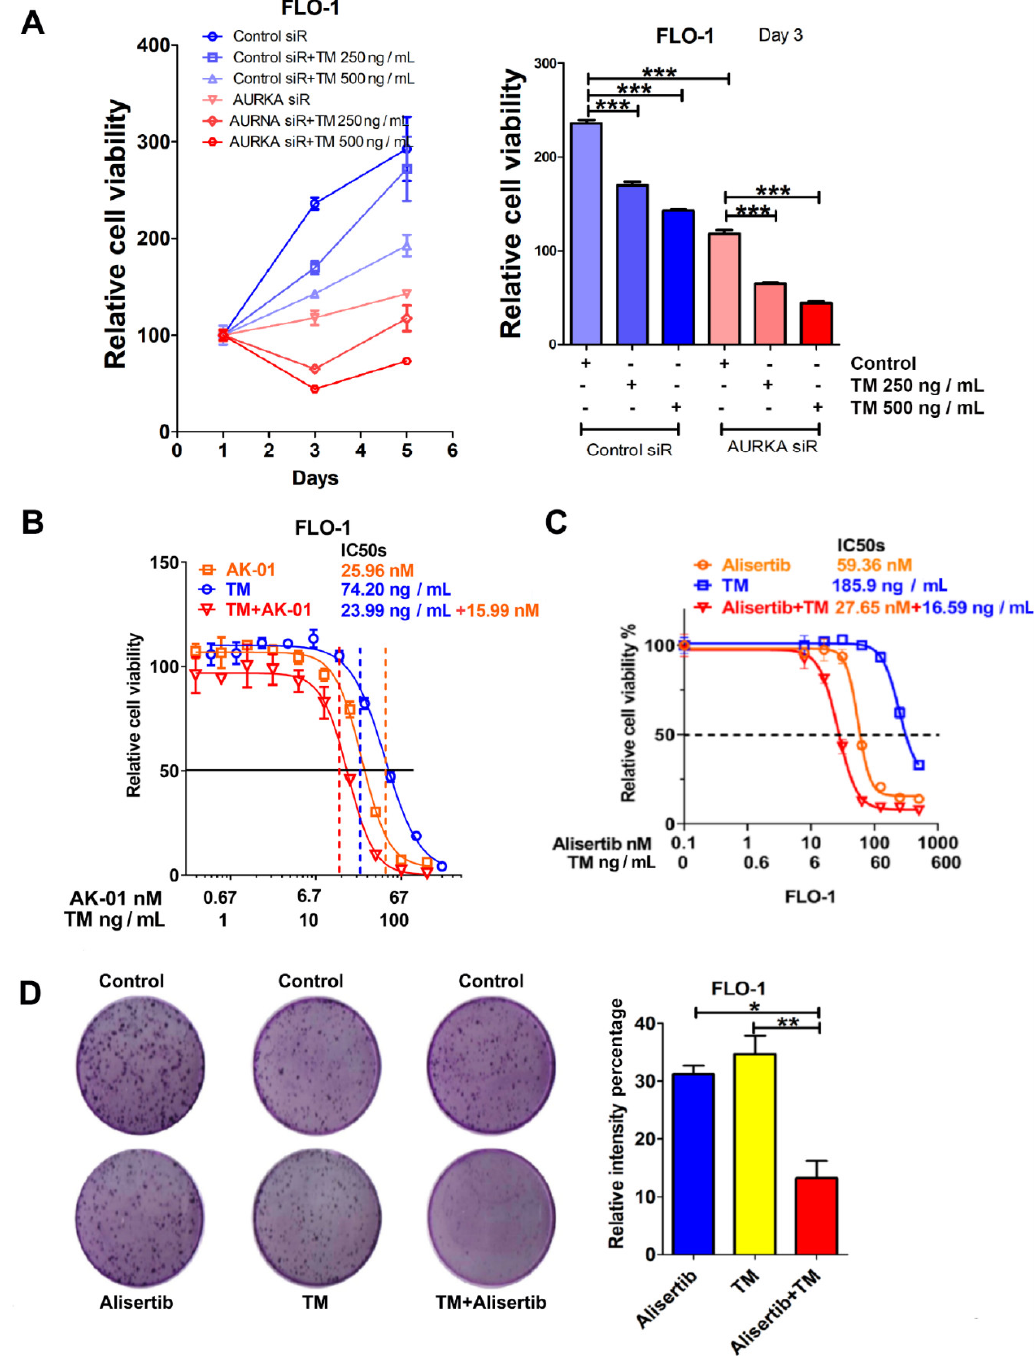
Figure 6. AURKA promotes cancer cell survival during tunicamycin-induced ER stress. ( A ) Left panel, ATP-Glo analysis of FLO-1 cells treated with control or tunicamycin (250 or 500 ng/mL for 3 or 5 days), combined with control siRNA or AURKA siRNA transfection. Right panel quantifies cell viability on day 3 of cells in ( A ). ( B ) ATP-Glo analysis of FLO-1 cells treated with tunicamycin, AURKA inhibitor AK-01, or a combination for 5 days. ( C ) Similar results as the left panel in FLO-1 cells treated with tunicamycin, AURKA inhibitor alisertib, or a combination for 5 days. ( D ) Left panel, representative clonogenic cell survival assay wells in FLO-1-treated tunicamycin, AURKA inhibitor alisertib, or a combination. Right panels, quantification of the left panel. * p < 0.05, ** p < 0.01, *** p < 0.001.